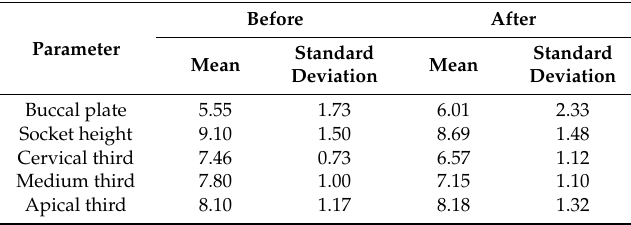
Table 1. Mediums and standard deviations (in mm) of the evaluated parameters in the TG1, before, and four months after, the procedure (blood clot and d-PTFE membrane for socket preservation), based on CT analysis.